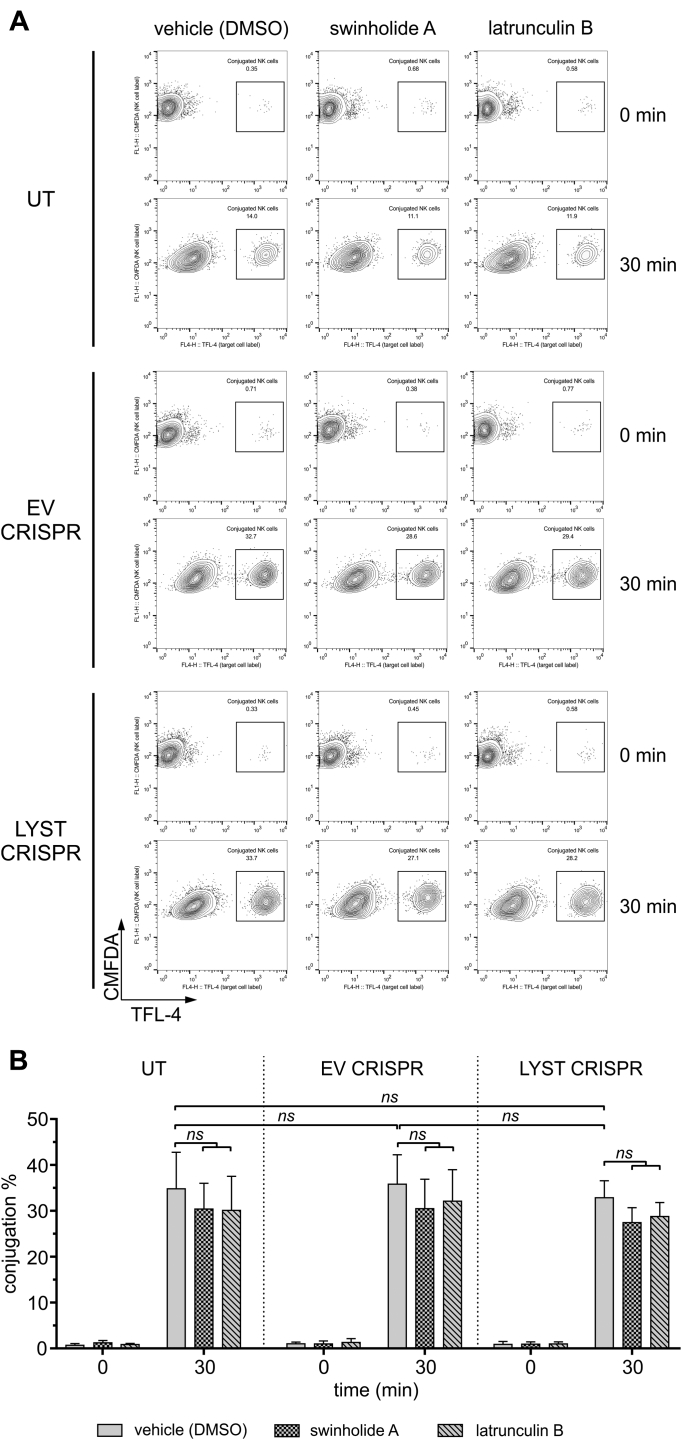
Conjugation of LYST-deficient NK cells. NK92mi cells, either untransduced (UT) or transduced with EV or LYST CRISPR were stained with CMFDA and then pretreated with dimethyl sulfoxide (DMSO; vehicle), 1 μmol/L swinholide A, or 0.5 μmol/L latrunculin B. Next, cells were mixed with TFL-4–labeled 721.221 target cells. Cells were allowed to form conjugates for 30 minutes at 37°C, fixed, and analyzed by using flow cytometry. Conjugates of NK and target cells were determined by measuring the percentage of CMFDA and TFL-4 double-positive cells from the total pool of live CMFDA-positive cells. A,Dot plots show gating strategy used and illustrate an example of the result. B, Graph shows conjugation summary data expressed as mean + SD values determined from 4 experiments.